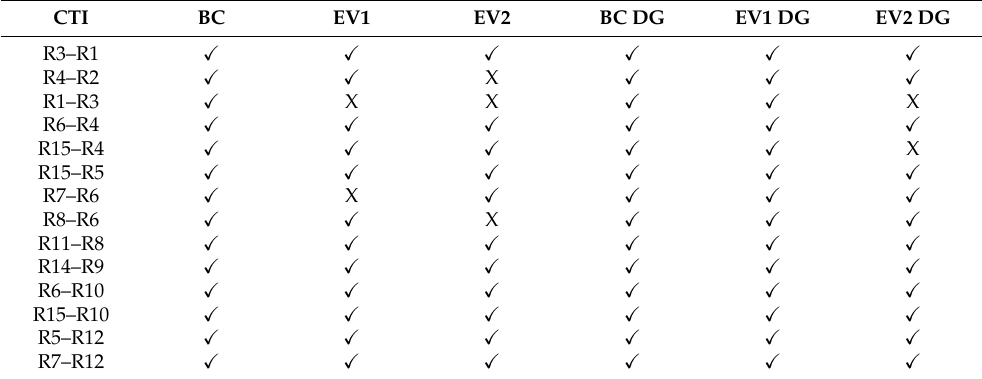
Table 9. Coordination time interval (CTI) for all